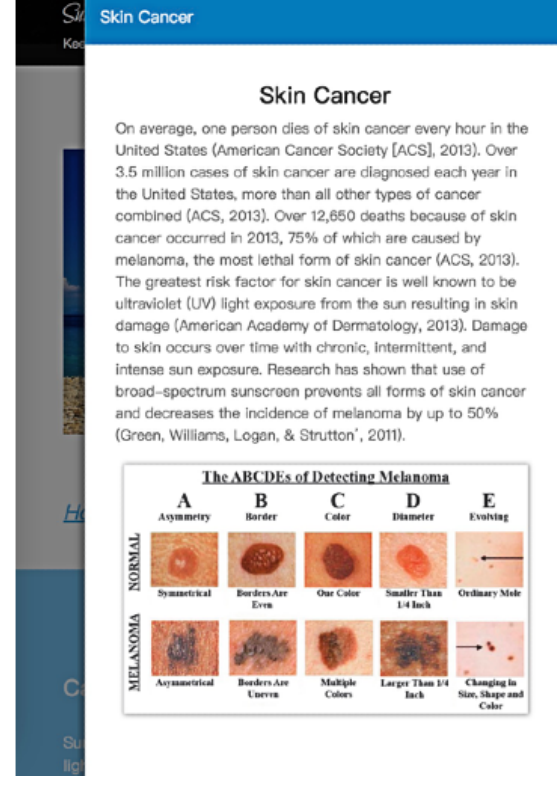
Figure 2. Example of the high message interactivity